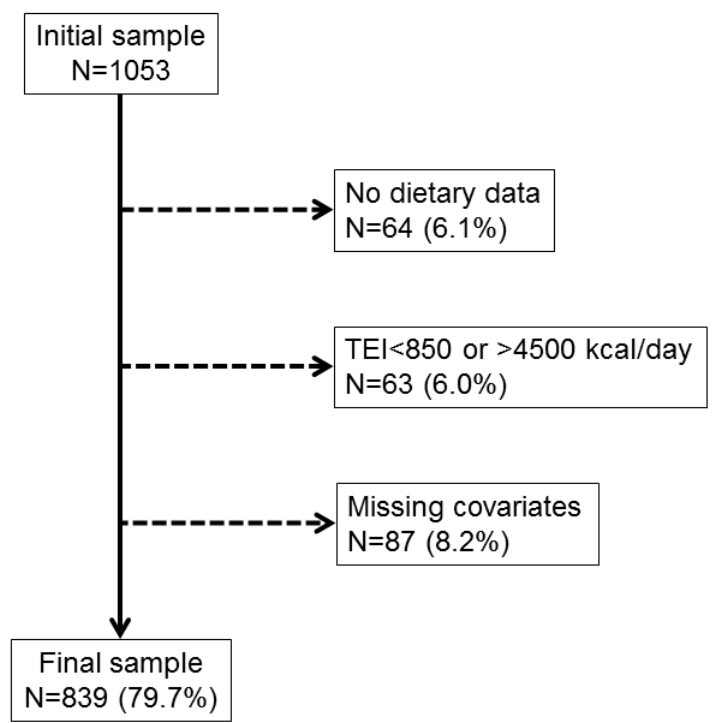
Figure 1. Flow chart of the study. Selection procedure of the participants of the OsteoLaus study, Lausanne, Switzerland. TEI, Total Energy Intake.